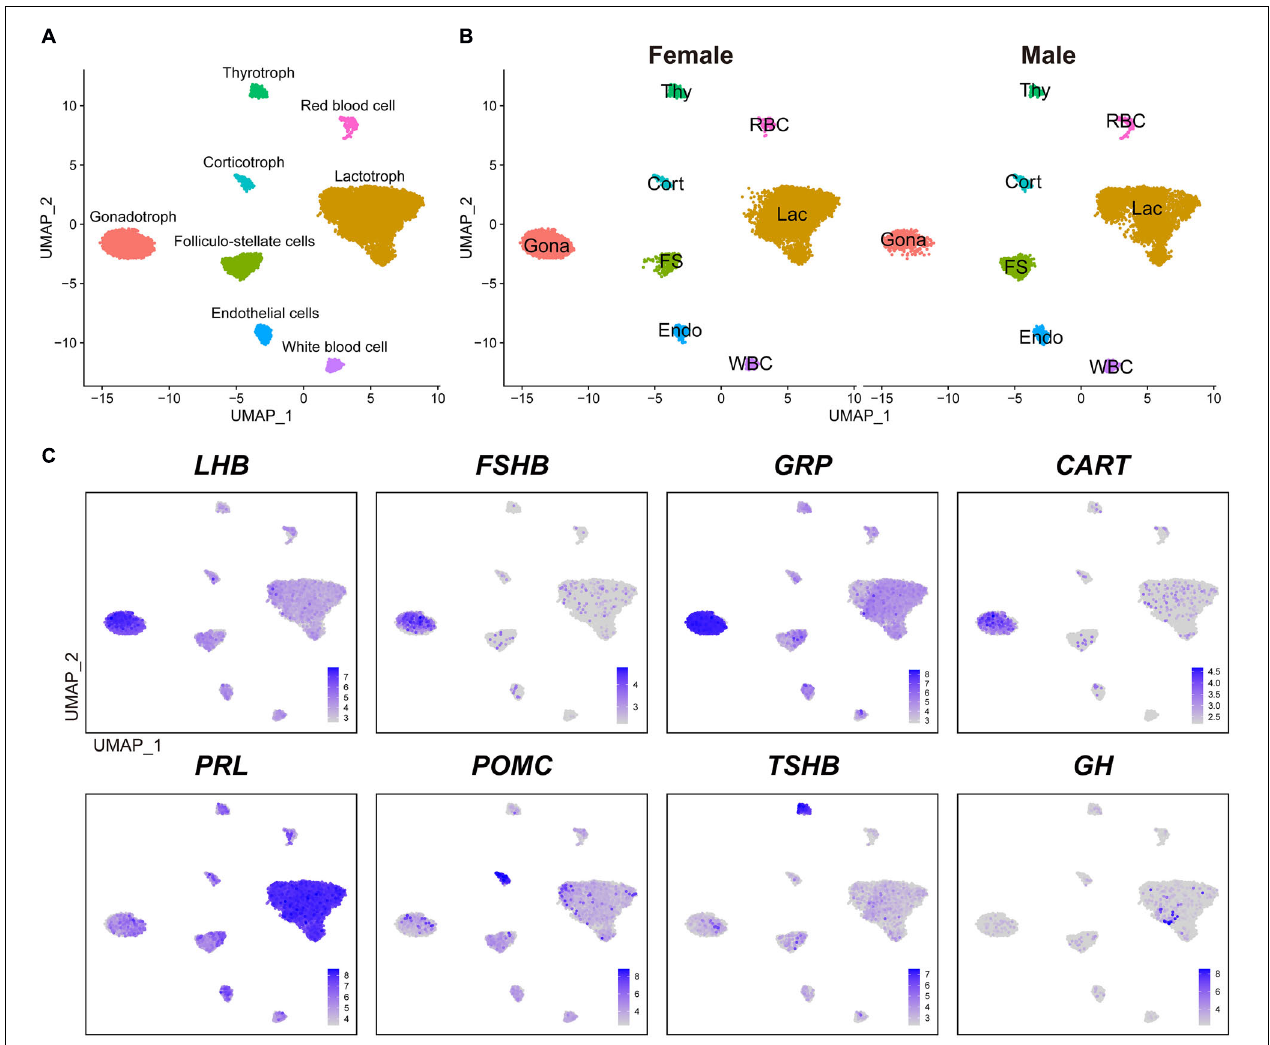
FIGURE 1 | The major cell clusters identified in adult chicken anterior pituitaries. (A) Uniform Manifold Approximation and Projection (UMAP) map showing the identified eight pituitary cell types based on the transcriptomes of 16, 652 cells. Cells are colored by Seurat clustering and annotated by cell types (each point represents a single cell). Gona, gonadotrophs; Lac, lactotrophs; Cort, corticotrophs; Thy, thyrotrophs; FS, folliculo-stellate cells; Endo, endothelial cells; WBC, white blood cells; RBC, red blood cells; UMAP, Uniform Manifold Approximation and Projection. (B) UMAP maps of the eight cell types identified in female (9, 919 cells) and male (6, 733 cells) adult chicken anterior pituitaries. (C) UMAP maps showing the abundant expression of pituitary hormone(s) in distinct cell clusters ( LHB , FSHB , GRP , and CART are abundantly expressed in Gona-cluster, PRL in Lac-cluster, POMC in Cort-cluster, TSHB in Thy-cluster, and GH ). Color bar indicates natural log transformed normalized